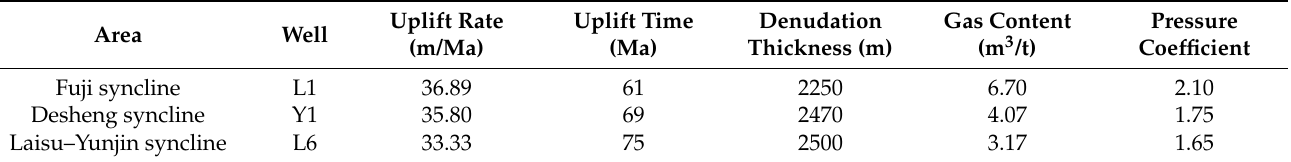
Figure 10. The burial history and thermal history of the typical wells in the Wufeng–Longmaxi Formation shale in the Luzhou area. ( a ) Burial history and thermal history of well L1; ( b ) burial history and thermal history of well L6; ( c ) burial history and thermal history of well Y1. Table 3. Statistical table of the shale gas accumulation factors in different wells in the Luzhou area.